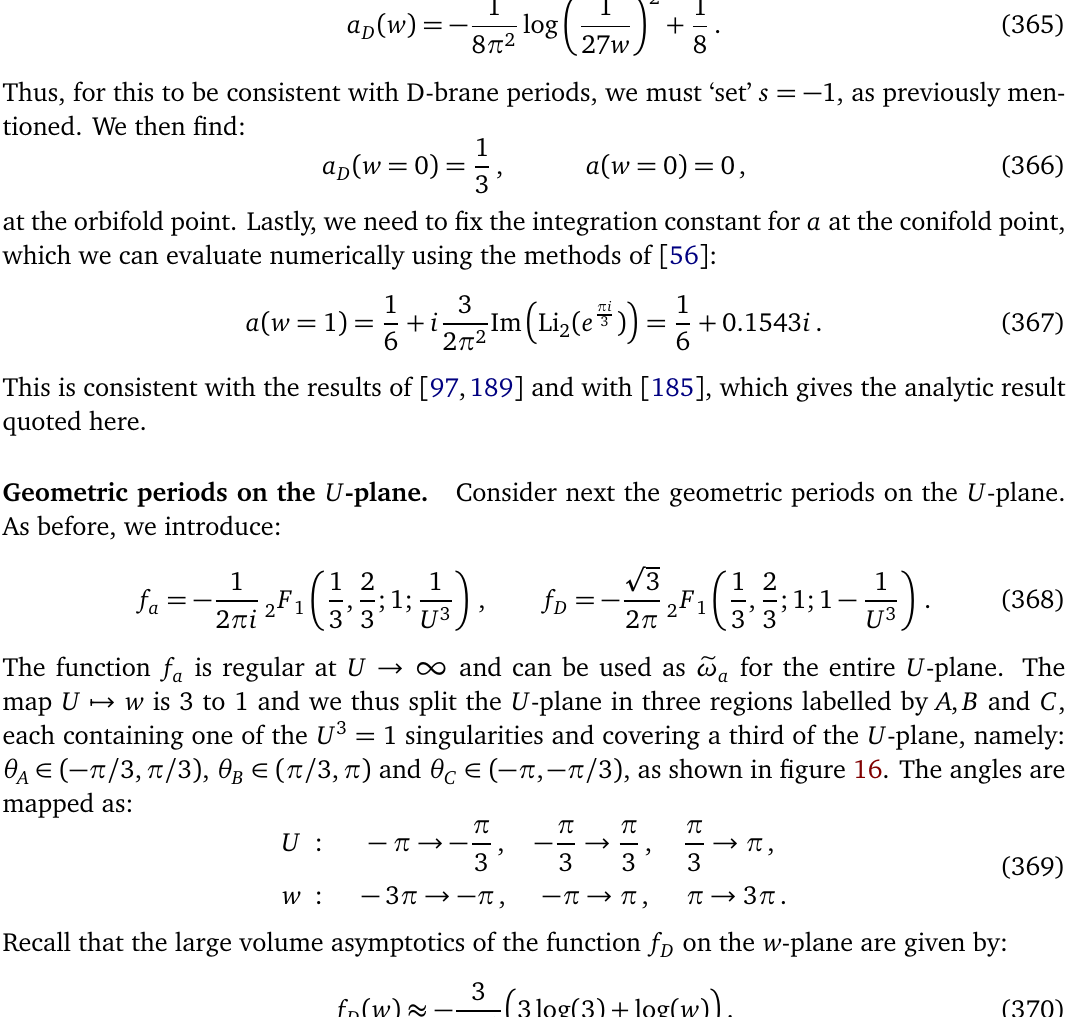
Figure 16: Choice of branch cuts for the physical periods a